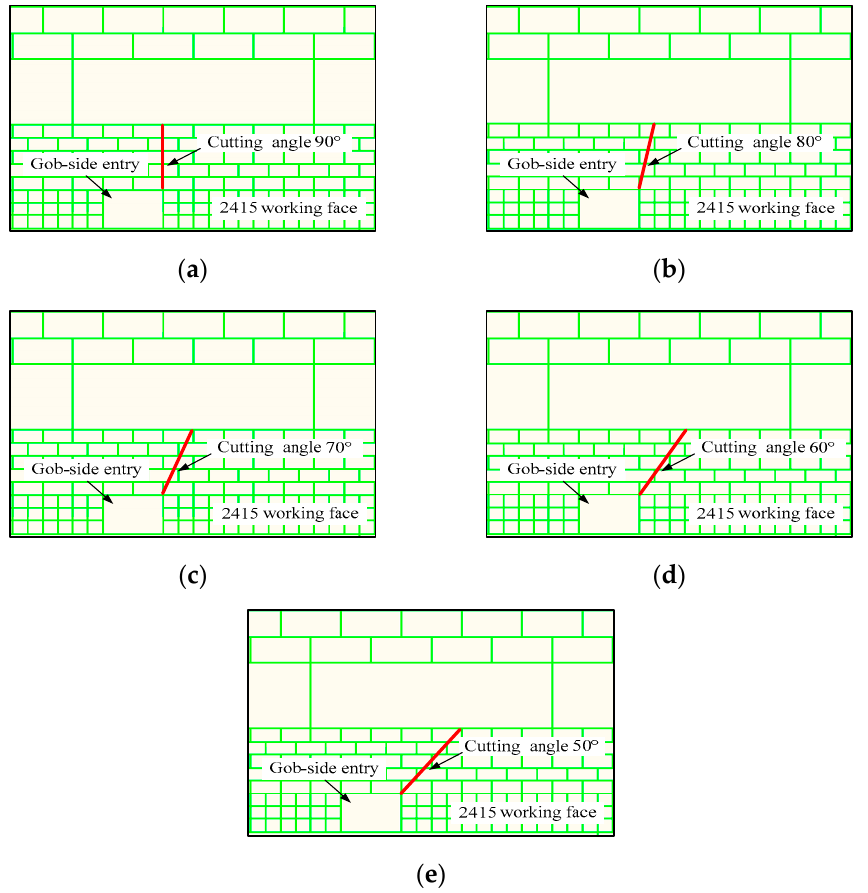
Figure 10. Numerical simulation schemes for different cutting angles. ( a ) Cutting angle 90°; ( b ) Cutting angle 80°; ( c ) Cutting angle 70°; ( d ) Cutting angle 60°; ( e ) Cutting angle 50°.